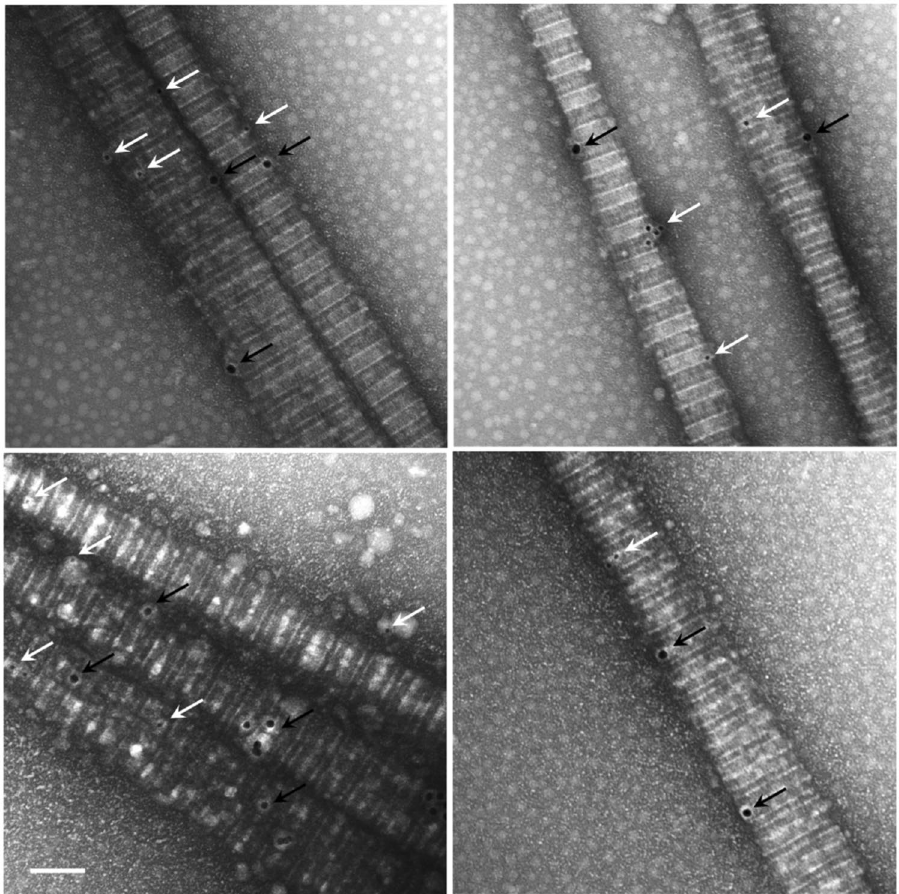
Figure 4. Representative transmission electron micrograph of fibrilized collagen with a Col-III to Col-I ratio of 50:50%. Col-I and Col-III were stained using gold nanoparticles of 18 nm and 12 nm in diameter, respectively. The larger dots represent the particles attached to tropocollagen type I, as pointed using black arrows, whereas the smaller ones are attached to tropocollagen type III, as pointed using white arrows. The scale bar represents 100 nm.